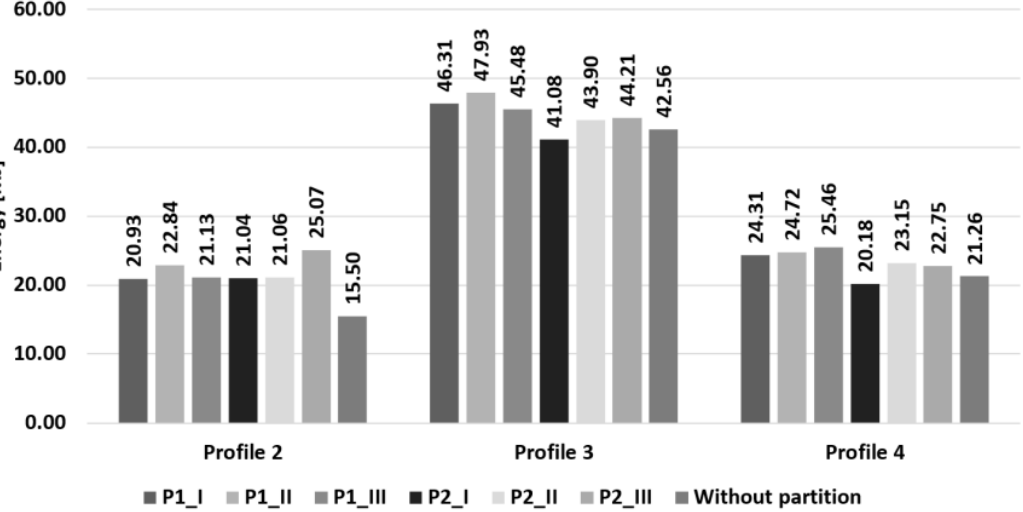
Figure 11. Amount of energy needed to heat up the water to 55 °C.